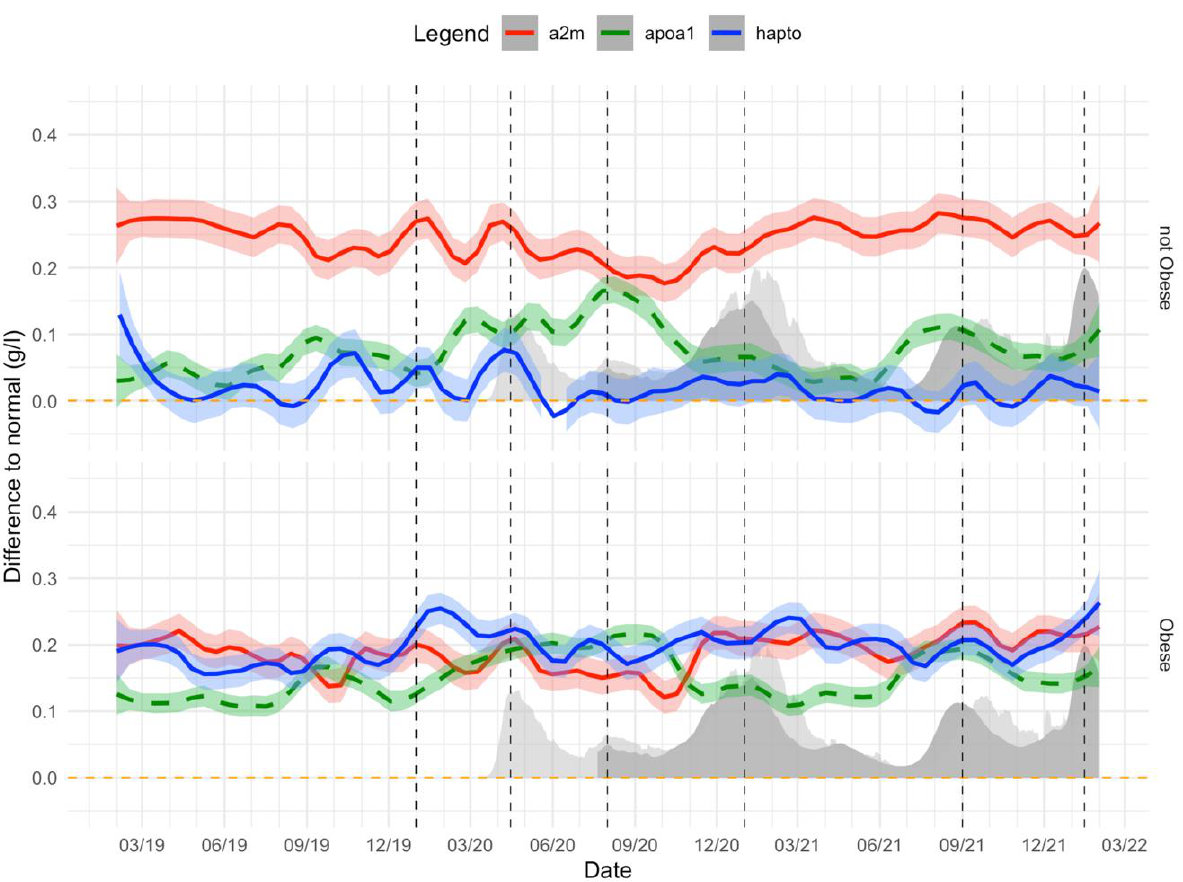
Figure 11. A2M, ApoA1, and haptoglobin levels before and during the COVID-19 pandemic. Impact of COVID-19 waves on A2M, ApoA1 and haptoglobin level differences with normal values before and during COVID-19 pandemic in obese and non-obese “NAFLD-Serum” subjects followed for metabolic liver risk (n = 135,911). X -axis is time, between January 2019 and February 2022. Dashed–vertical black lines show the different COVID-19 waves. In light gray and dark gray are the standardized COVID-19-related death and hospitalization rates, respectively, in the USA. The red line, blue line, and dashed–green line are the 7-day rolling mean difference and %95CI between the observed A2M, haptoglobin, and negative Apoa1 concentration, respectively, and the expected normal values for these subjects adjusted by their age and gender.